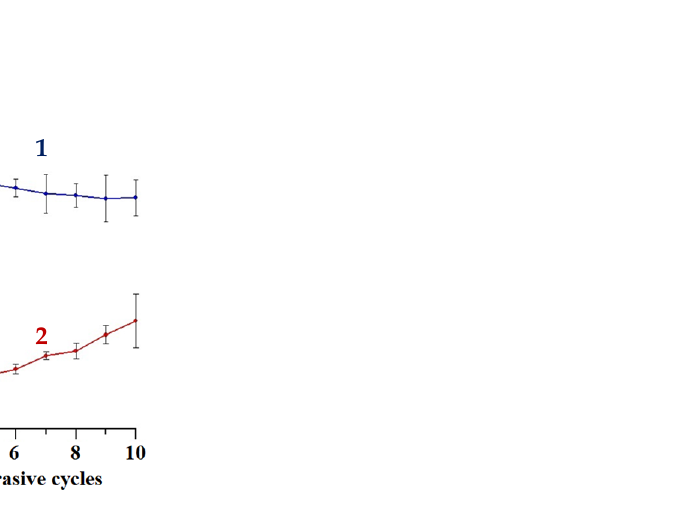
( b ) Figure 5. EDS elemental maps for the distribution of ( a ) carbon (orange dots) and fluorine (green); ( b ) tungsten (red) and oxygen (blue) on the surface of superhydrophobic tungsten sample ob- tained by regime 13 after 10 h of oscillated sand abrasion test. To additionally test the abrasion resistance of the coating, we applied the falling sand method [43], as described above. Compared to the oscillated sand test, this method sub- jects the surface to a more severe load. On one hand, the tangential (parallel to the sam- ple’s surface) component of the velocity of the sand particles in the falling sand method with parameters used in this work is about 4 times larger than in the oscillating sand method (1.4 m/s versus 0.33 m/s). On the other hand, the falling sand particles exert not only abrasive, but also an impact load on the test surface. This kind of load might be es- pecially detrimental for brittle materials, such as tungsten oxide. Figure 6 presents data on the variation in the wettability during 10 cycles of the falling sand abrasive load. As expected, in this method, the degradation of the superhydrophobic coating was